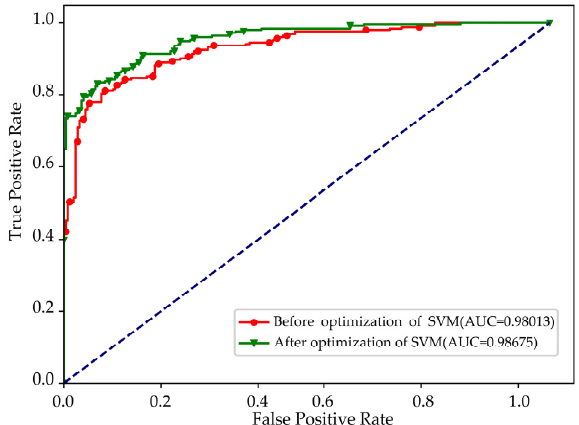
Figure 11. ROC curve before and after